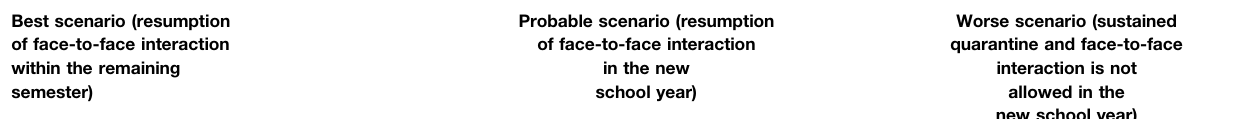
TABLE 10 | Scenario